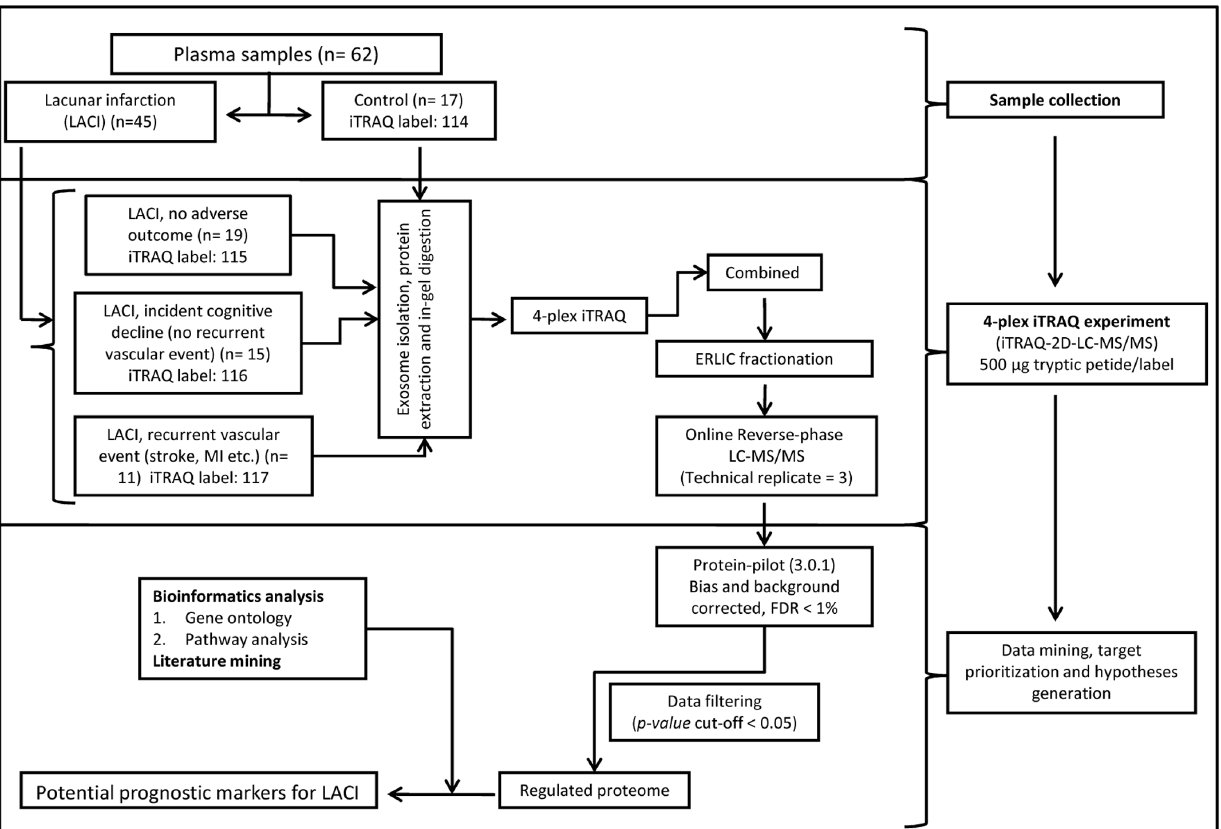
Figure 1. Schematic representation of the experimental design. ERLIC, electrostatic repulsion hydrophilic interaction chromatography.